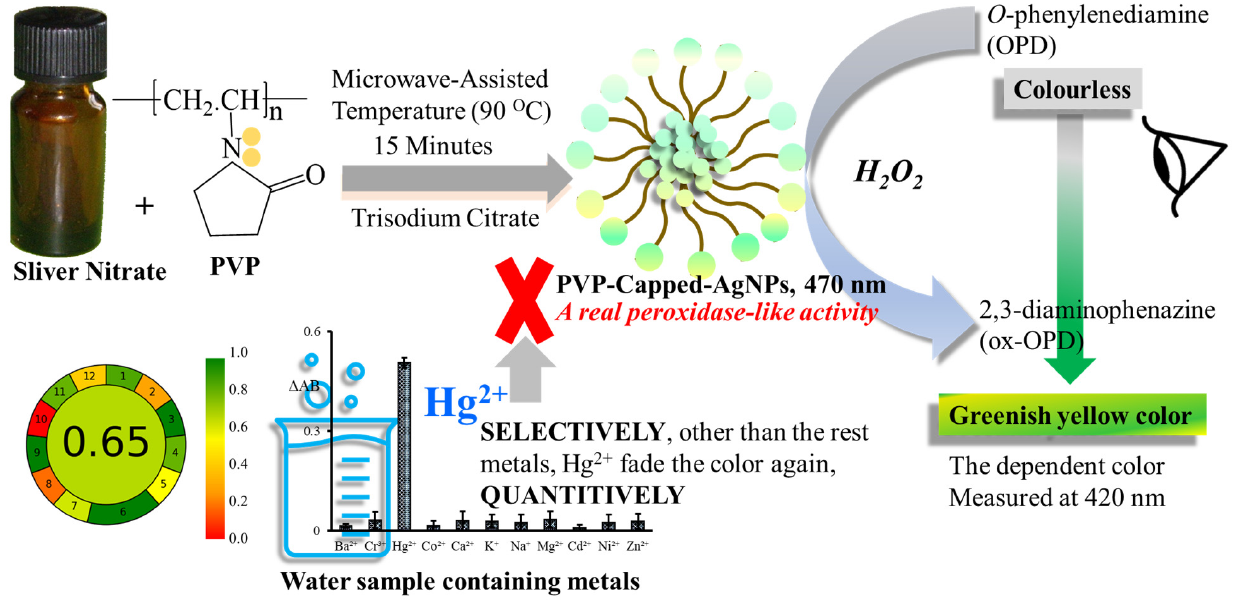
Figure 1. Schematic of PVP-AgNPs composite synthesis and their mechanism for Hg 2+ detection either by the spectrophotometric technique (at very low concentrations of Hg 2+ ) or by the naked eye (at micro-levels concentrations of Hg 2+